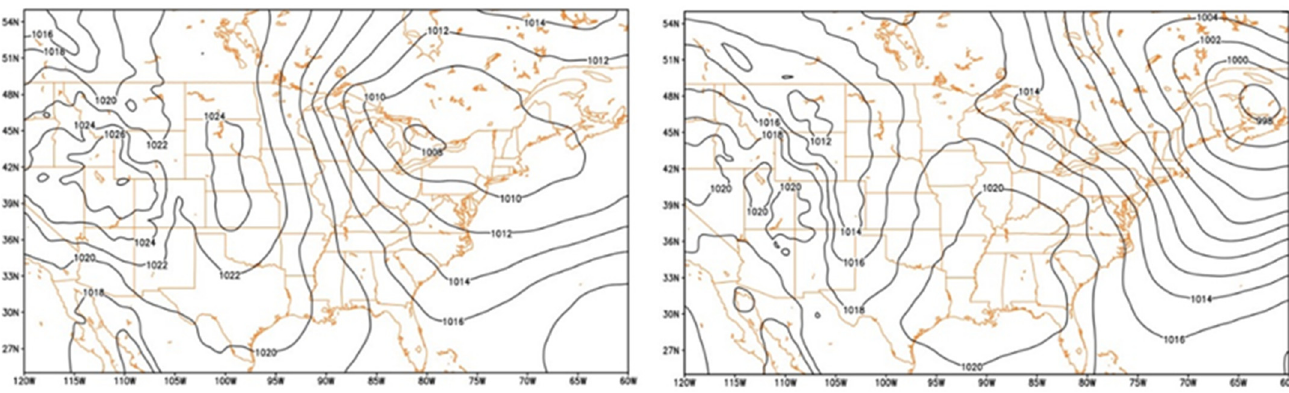
Figure 2. From [35] highlighting the evolution of the common dipole structure present during a LES event off the eastern Great Lakes (Lakes Erie and Ontario).